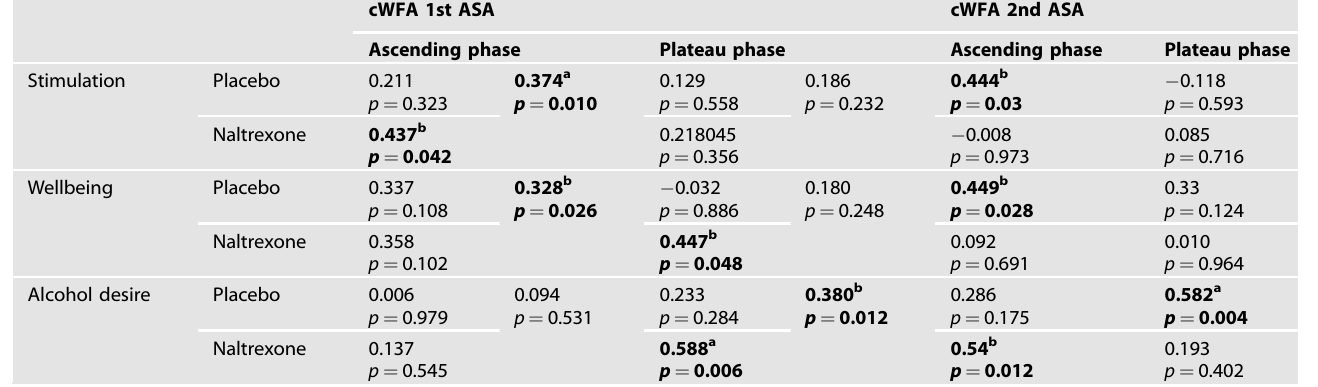
Table 2. Spearman ’ s rho correlation coef fi cients between cumulative work for alcohol (cWFA) and slopes of subjective responses in the ascending and plateau phases of the fi rst and second alcohol self-administration (ASA) session in the intention-to-treat (ITT)